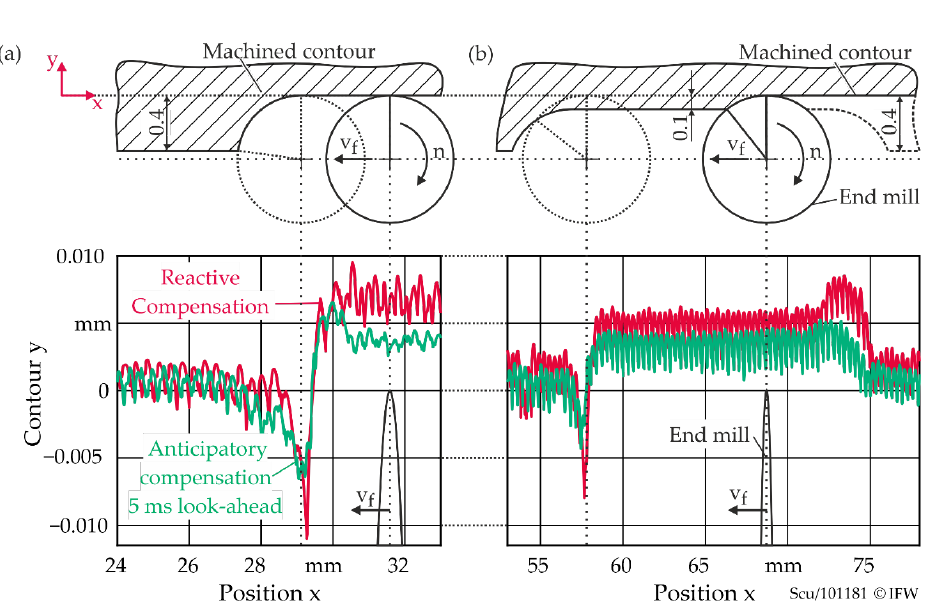
Figure 11. Measured contours for the experiments with anticipatory compensation: ( a ) transition from a e = 0 to 0.4 mm; ( b ) transition from a e = 0.1 mm to 0.4 mm.